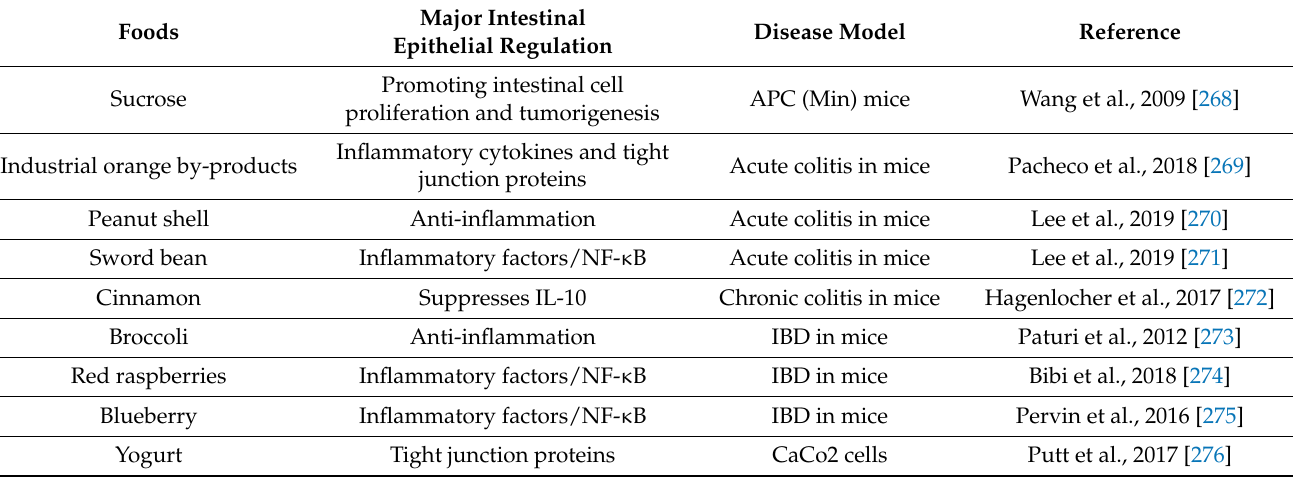
Table 5. Major foods that help leaky